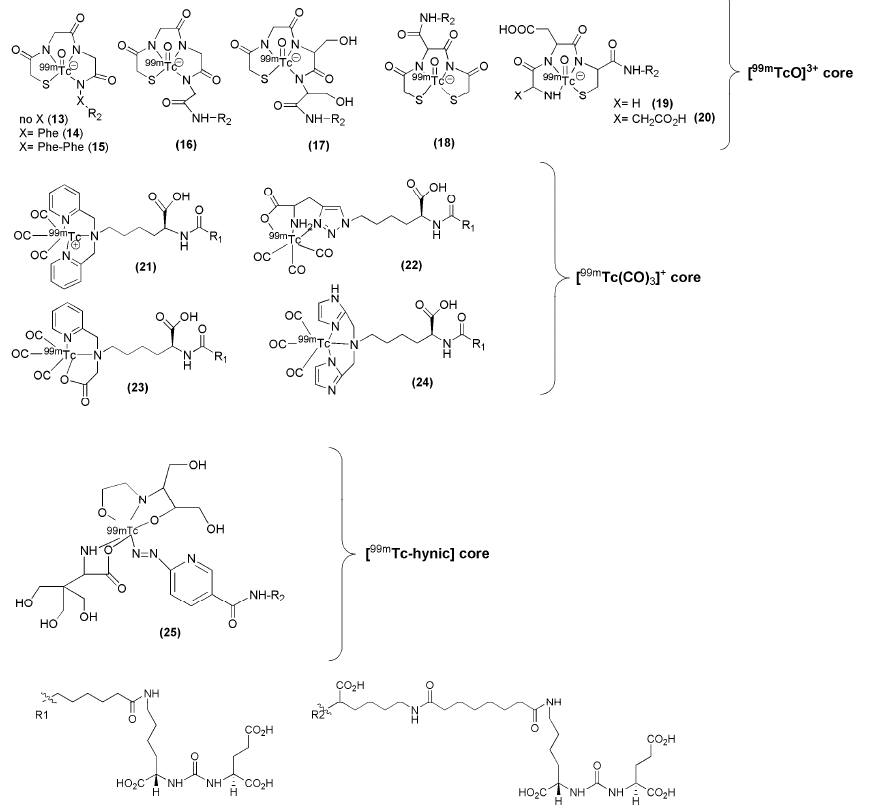
Figure 6. PSMA-inhibitors labeled via the ([ 99m TcO] 3+ ) ( 13 – 20 ), ([ 99m Tc(CO) 3 ] + ) ( 21 – 24 ) and ( 99m Tc-hynic) ( 25 ) core [98,99]. Table 1. Affinity, labeling and lipophilicity data of the 99m Tc-labeled PSMA inhibitors ( 13 – 25 ).